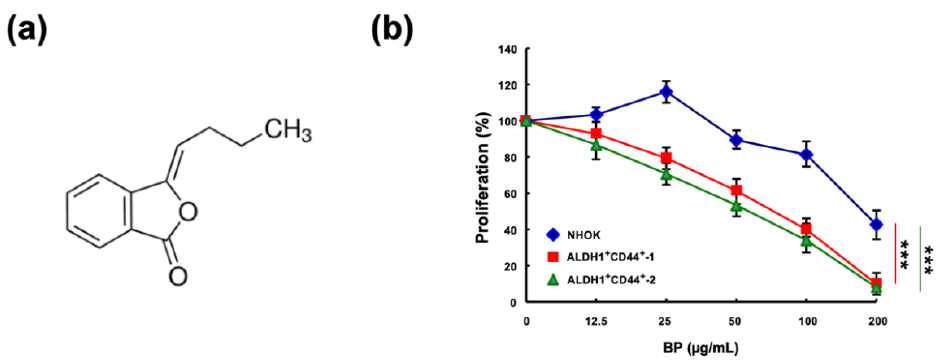
Figure 1. The cytotoxic effect of butylidenephthalide on the viability of normal human oral keratinocyte (NHOK) and patient-derived ALDH1 + /CD44 + cells. ( a ) Chemical structures of butylidenephthalide; MTT assay was utilized to examine the cell viability of ( b ) NHOK and two patient-derived ALDH1 + /CD44 + cells in response to butylidenephthalide at 12.5, 25, 50, 100, and 200 µ g/mL. Results are presented as means ± SD of three independent experiments; *** p < 0.001 compared to NHOK . Butylidenephthalide (BP).